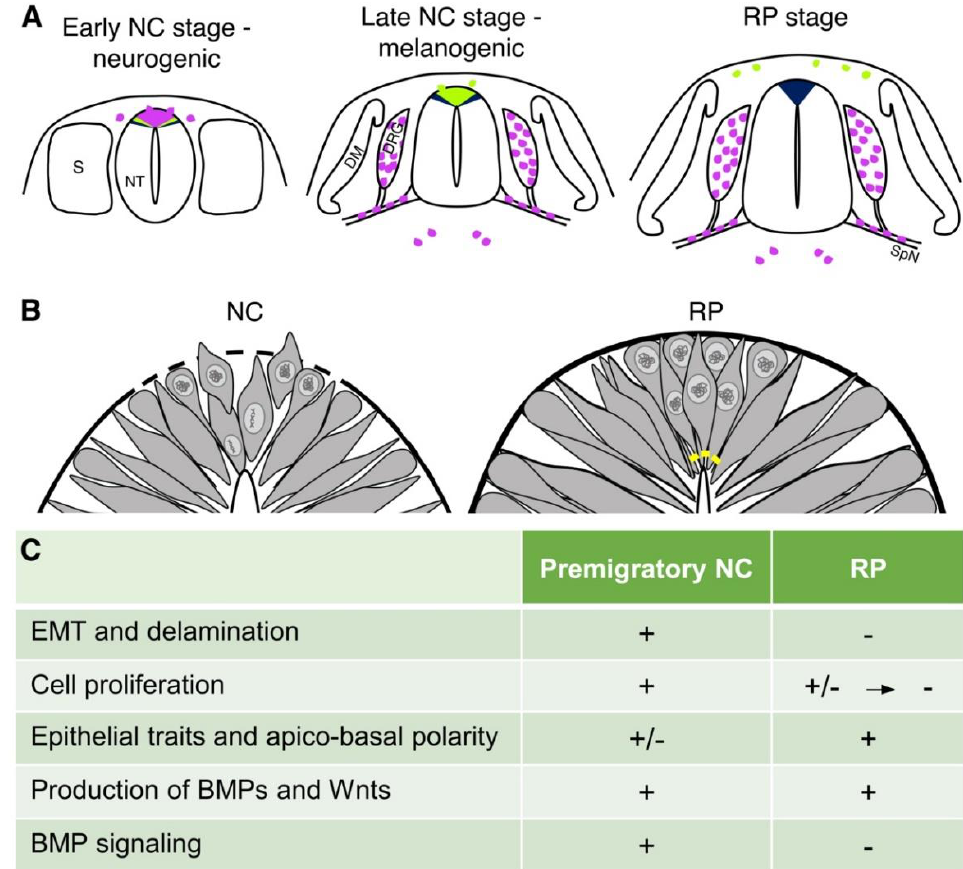
Figure 1. The dynamics of the dorsal NT—from premigratory NC to definitive RP. ( A ) Schematic representation of three consecutive stages. The early emigrating NC (purple) is neurogenic—premigratory NC cells at trunk levels express Foxd3 , Snai2 , Sox9 , etc; upon delamination they migrate dorso-ventrally to give rise mainly to neural and glial derivatives. A subset of NC-derived Schwann cell progenitors also generates hypaxial melanocytes. The late NC (green) is melanogenic—premigratory NC cells downregulate expression of the above genes, and as they leave the NT they migrate dorso-laterally and differentiate into epaxial melanocytes. RP progenitors (blue) are generated ventral to the premigratory NC and adopt their final position following the end of NC emigration. ( B ) Differences in cellular behavior between premigratory NC cells and definitive RP cells. Shortly prior to emigration, NC cells loose epithelial traits and their nuclei are distributed throughout the apico-basal extent of the dorsal NT (left panel). Upon formation of the RP, cells regain epithelial traits and apico-basal polarity with nuclei mainly concentrated at the basal half of the epithelium. Yellow squares represent apical adherens junctions (right panel). ( C ) A summary of various characteristics of premigratory NC and RP stages (see text for details). Abbreviations; DM, dermomyotome, DRG, dorsal root ganglion, NC, neural crest; NT, neural tube; S, somite; SpN, spinal